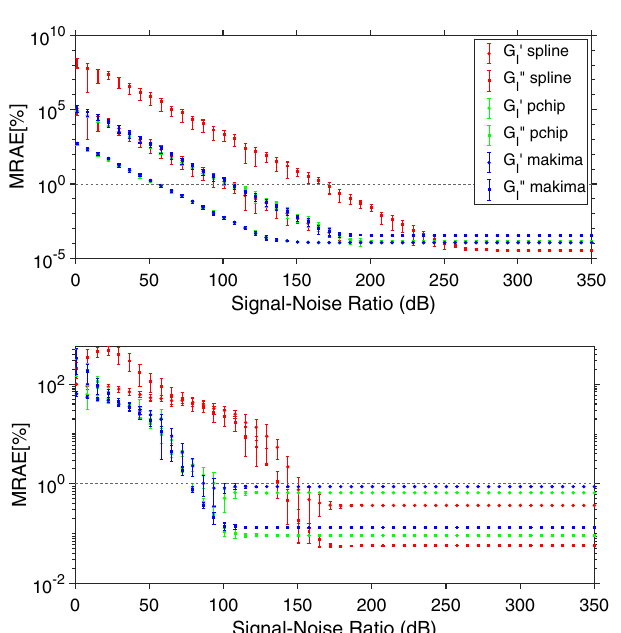
Figure 7. Mean relative absolute error (MRAE) of the frequency-dependent complex moduli determined by Fourier transforming (via Eq. 1) the interpolation functions shown in Fig. 5 (top & bottom respectively) for SNR values ranging from 1 to 350 dB. The error bars represent one standard deviation of uncertainty calculated over ten